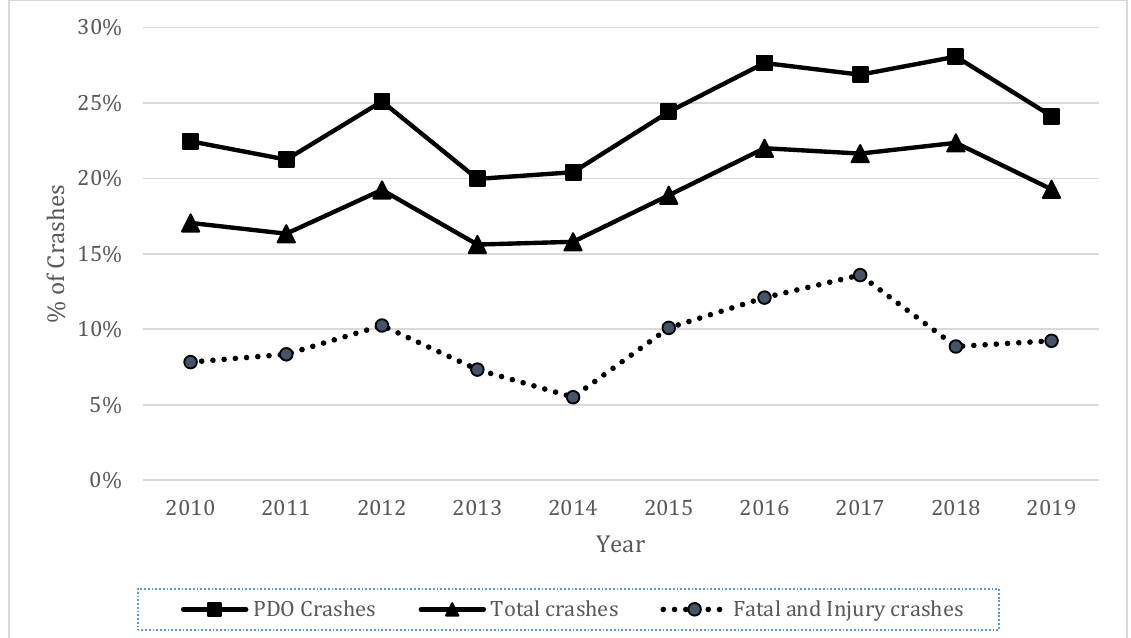
Figure 1 (a): Percentage of the total, injury, and PDO animal-vehicle crashes to that of total crashes, total injury crashes, and total PDO